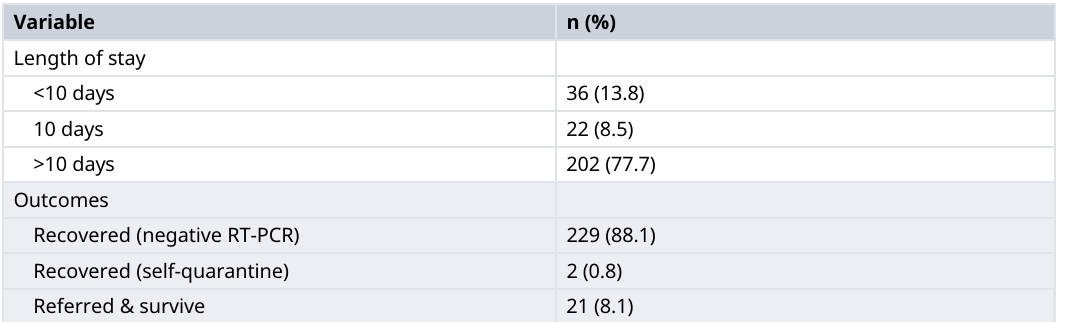
Table 3. Clinical outcomes of COVID-19 patients with diabetes mellitus